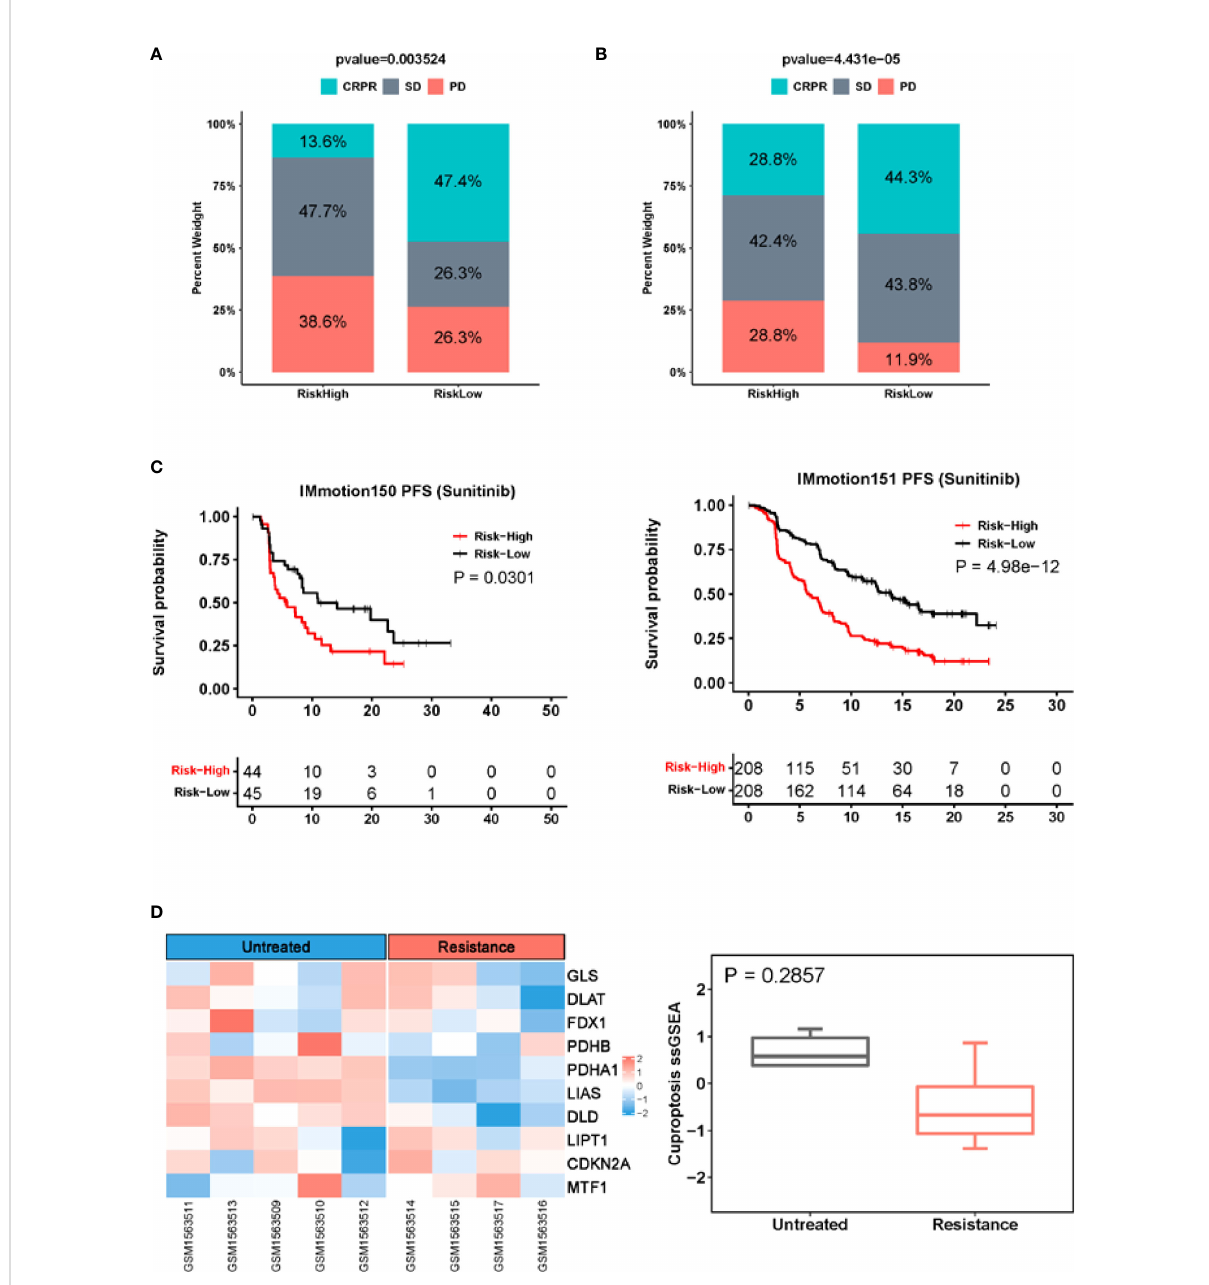
FIGURE 7 The CuAGS-13 score prediction of patient response to Sunitinib in ccRCC. (A) Differences in response rates between the CuAGS-13 high- and low-risk group patients treated with Sunitinib in IMmotion150 trial. (B) Differences in response rates between the CuAGS-13 high- and low-risk group patients treated with Sunitinib in IMmotion151 trial. (C) Signi fi cant association between shorter PFS and the CuAGS-13 high-risk group patients treated with Sunitinib in IMmotion150 trial (left) and IMmotion151 trial (right). (D) The lower cuproptosis score in Sunitinib-resistant PDX tumors. Microarray data in fi ve untreated and four Sunitinib-resistant PDX tumors were analyzed for their cuproptosis score. Left panel: Heatmap showing expression of 10 cuproptosis factors. Right panel: The cuproptosis score in untreated and Sunitinib-resistant PDX tumors. A cuproptosis score was calculated using